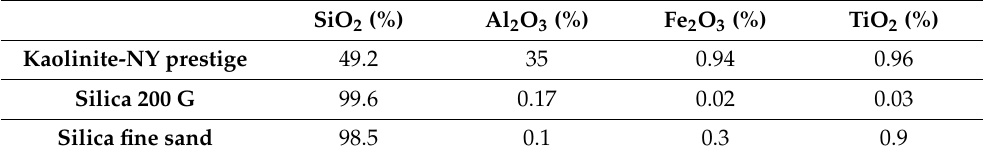
Table 1. Synthetic slurry mineralogy.